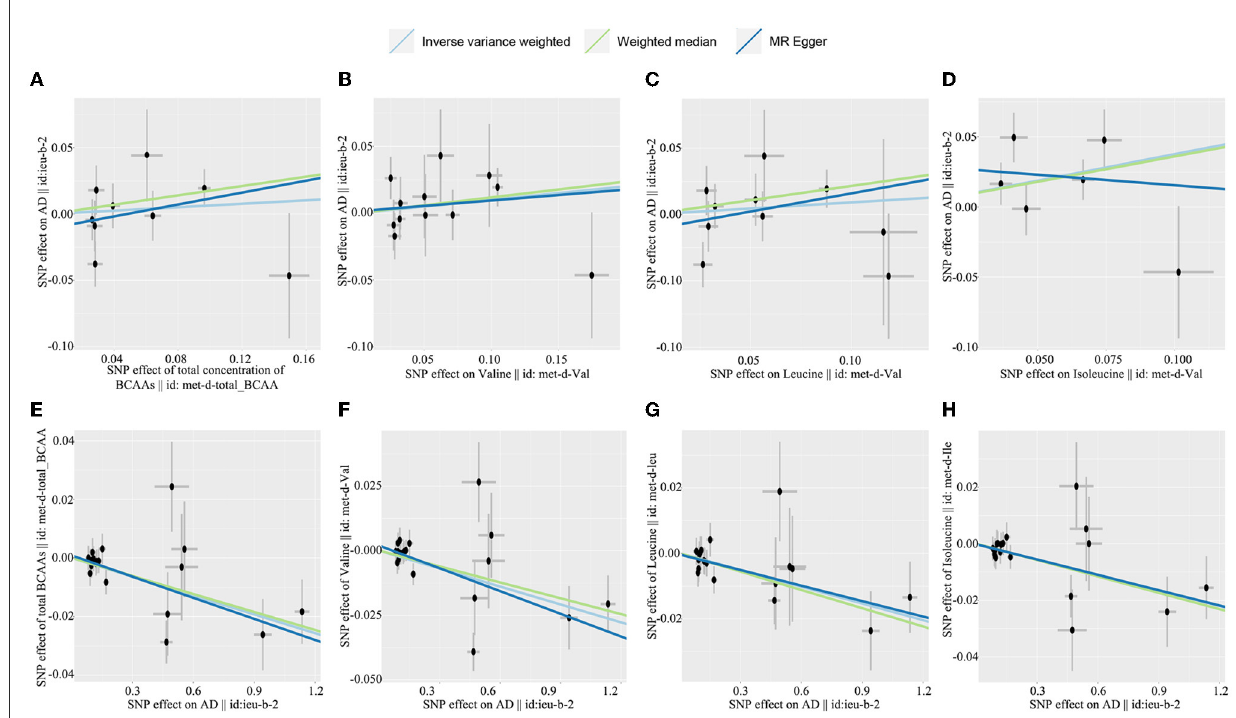
FIGURE2 Scatterplot of the genetic causal effect sbetween BCAAs level the risk of AD. (A) Total BCAAs on AD, (B) valine on AD, (C) leucine on AD, (D) isoleucine on AD, (E) AD on total BCAAs, (F) AD on valine, (G) AD on leucine, (H) AD on isoleucine. BCAAs, branched-chain amino acids; AD, Alzheimer’s